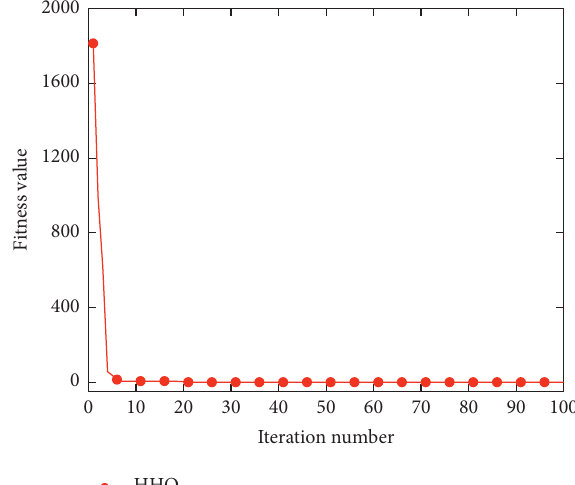
Figure 18: The evolution curve of fitness